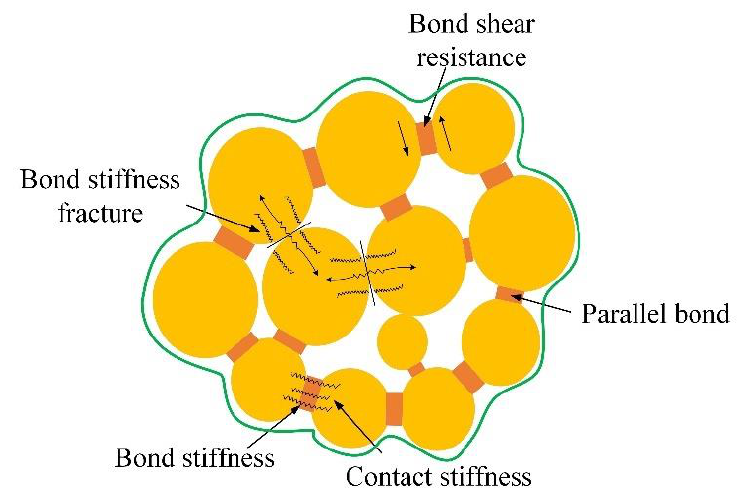
Figure 17. Parallel bonding model.